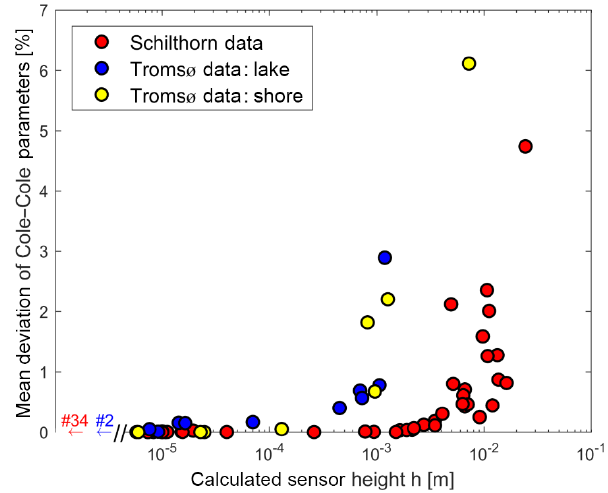
Figure 6. Mean deviation of Cole–Cole parameters vs. sensor height. The deviation was calculated by performing the single site inversion with and without the determination of sensor height and calculating the ratio for all the five Cole–Cole parameters. The data are separately shown for all measurements at profile B-SCH (Schilthorn, red) and for Lake Prestvannet (Tromsø) on the lake (blue) and on shore (yellow). Values for sensor heights lower than 5 × 10 − 6 m are not displayed but their number of measurements is